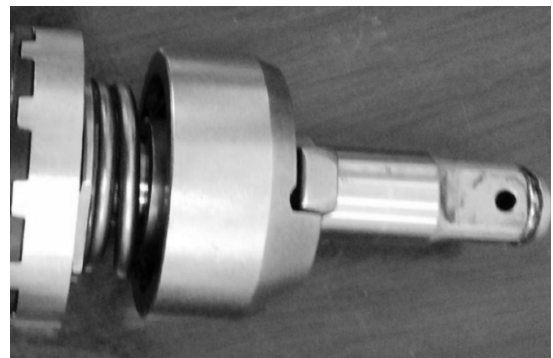
Figure 12. Mechanical structure of impact wrench.